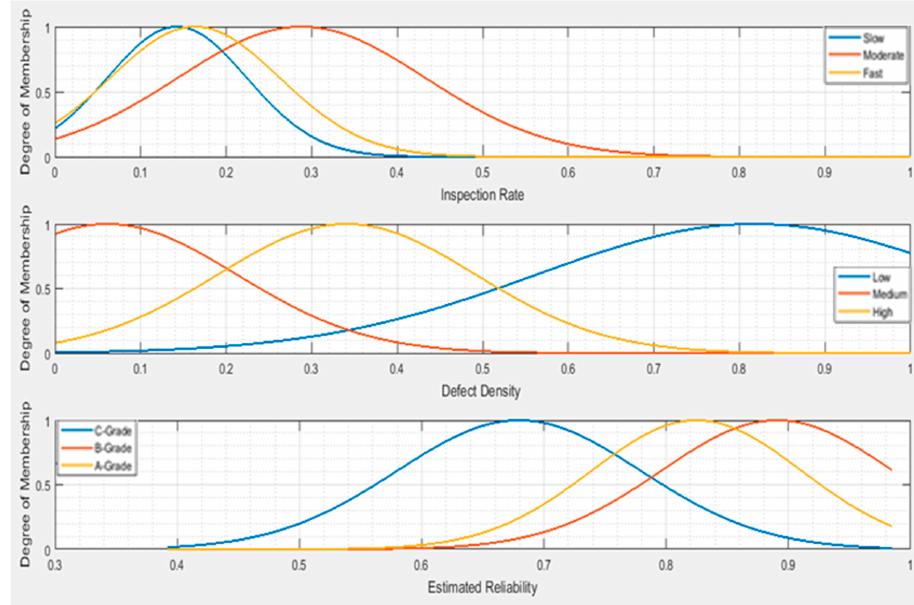
Electronics 2023 , 12 , x FOR PEER REVIEW Figure 5. Input–output membership function of self-learning (FCM) M-FIS. Figure 5. Input–output membership function of self-learning (FCM) M-FIS.